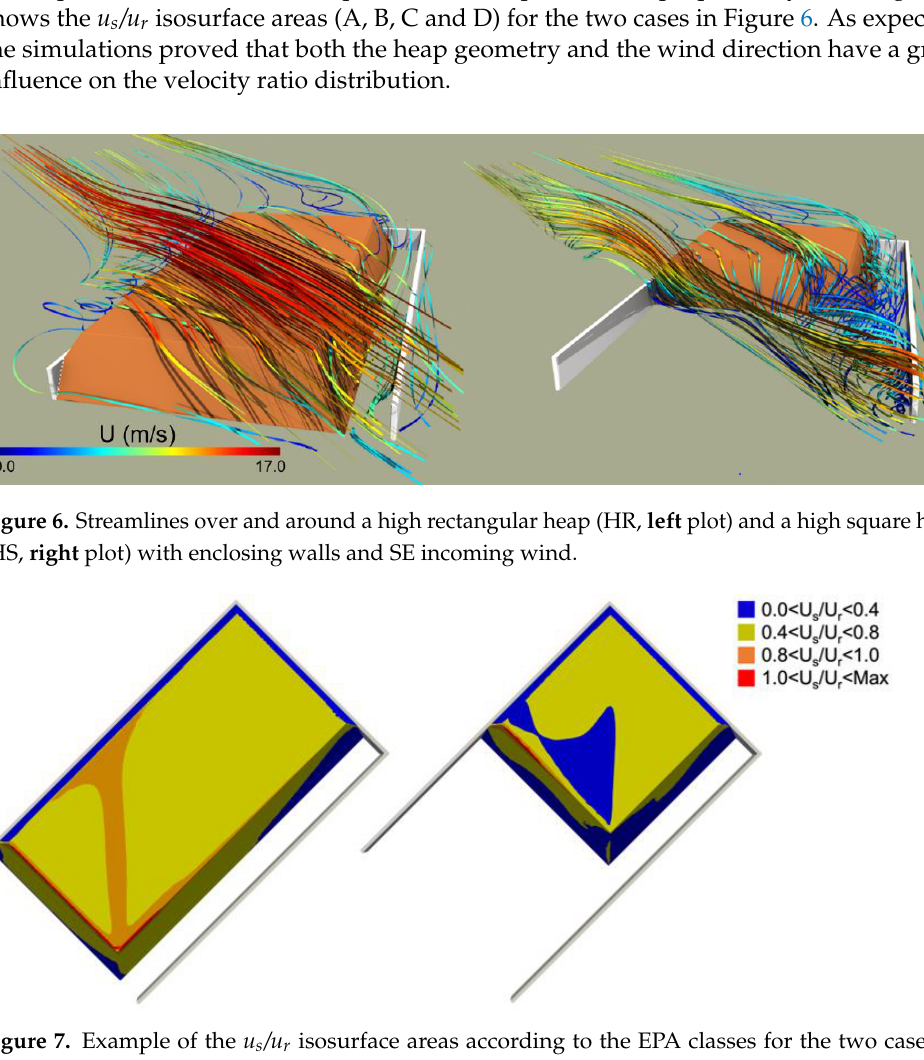
Figure 7. Example of the u s /u r isosurface areas according to the EPA classes for the two cases in Figure 6 (HR, left plot and HS, right plot).